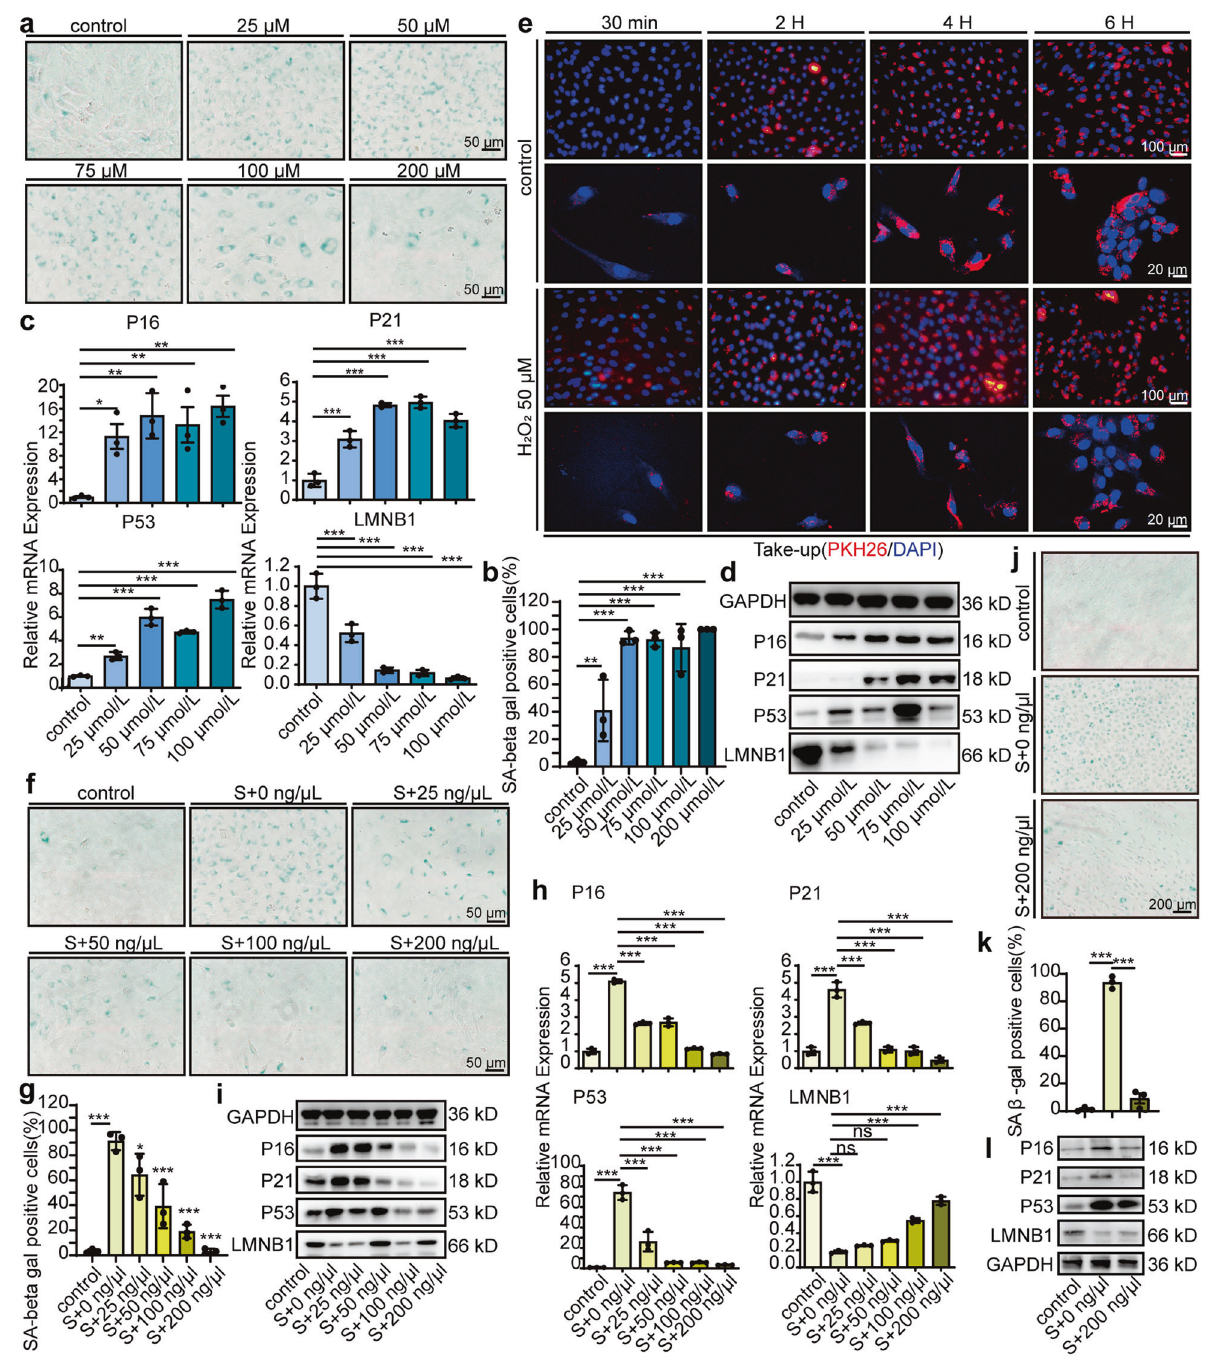
Fig. 2 MSC-sEV mitigated senescence in HUVECs in vitro. Cultures exposed to H 2 O 2 (25 μ M, 50 μ M, 75 μ M, 100 μ M, 200 μ M, 2 h) or PBS (control) as showing in the fi gure. a Representative images of senescence-associated β -galactosidase (SA β -gal) staining (scale bar, 50 μ m). b Quantitation of SA β -gal-positive cells in HUVEC. c Quantitative real-time PCR (qRT-PCR) of the senescence markers P16, P21, P53, and LMNB1 mRNA in HUVEC after 24 h exposure to H 2 O 2 . n = 3, * p < 0.05, ** p < 0.01, *** p < 0.001. d Representative images of western blot analysis showing the senescence markers P16, P21, P53, and LMNB1 in HUVEC after 48 h of exposure to H 2 O 2 . e Representative images of MSC-sEV uptake by HUVEC pretreated with or without H 2 O 2 (50 μ M, 2 h). HUVECs incubated with 200 ng/ μ L PKH26-labeled MSC-sEV for the indicated times, and uptake of MSC-sEV was determined by fl uorescence microscopy (scale bar, 100 μ m) and fl uorescence confocal microscopy (scale bar, 20 μ m). Next, HUVECs were incubated with 0 ng/ μ L, 25 ng/ μ L, 50 ng/ μ L, 100 ng/ μ L and 200 ng/ μ L MSC-sEV for 24 h ( c ) and 48 h ( a , d ) after pretreated with H 2 O 2 (50 μ M, 2 h). f Representative images of SA β -gal staining in HUVECs (scale bar, 50 μ m). g Quantitation of SA β -gal- positive cells in HUVEC. n = 3, ** p < 0.01, *** p < 0.001. h qRT-PCR of the senescence markers P16, P21, P53, and LMNB1 mRNA in HUVEC. n = 3, * p < 0.05, ** p < 0.01, *** p < 0.001. i Representative images of western blot analysis showing the change of senescence markers P16, P21, P53, and LMNB1 in HUVECs. j Representative images of SA β -gal staining in high-glucose-induced senescent HUVECs (scale bar, 200 μ m). k Quantitation of SA β -gal-positive cells in high-glucose-induced senescent HUVEC. n = 3, *** p < 0.001. l Representative images of western blot analysis showing the change of senescence markers P16, P21, P53, and LMNB1 in high-glucose-induced senescent HUVEC